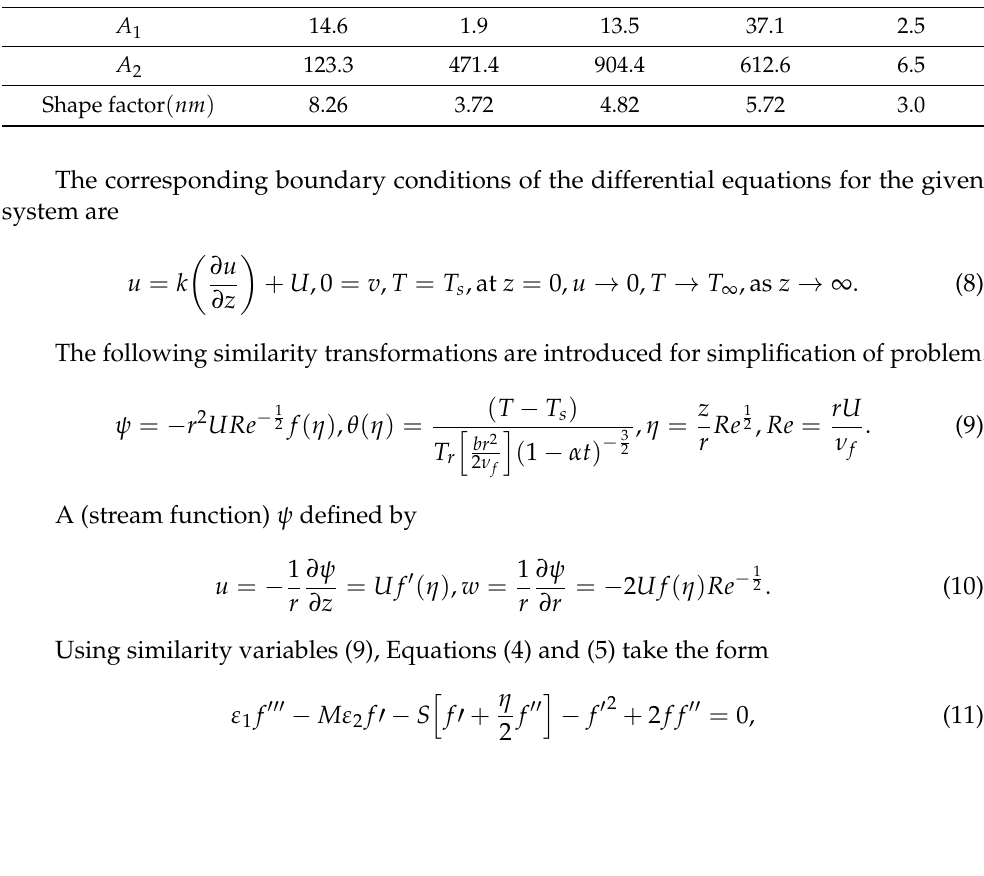
Table 2. Shapes factor and viscosity co-efficient corresponding to five distinct nanoparticles. Nanoparticle